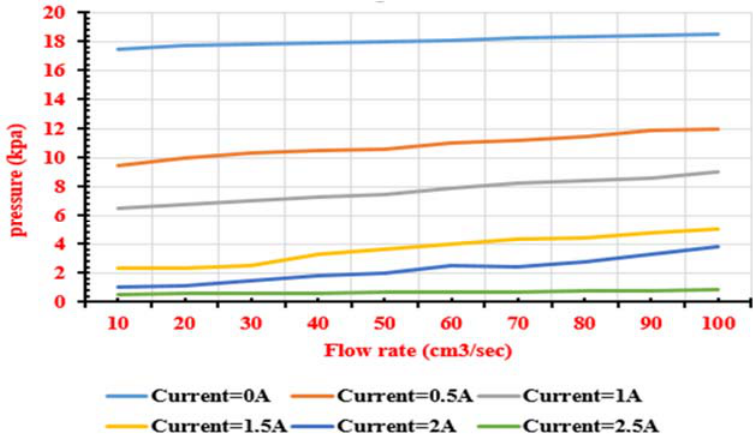
Fig. 10. Relation between flow rate and pressure drop for different currents.